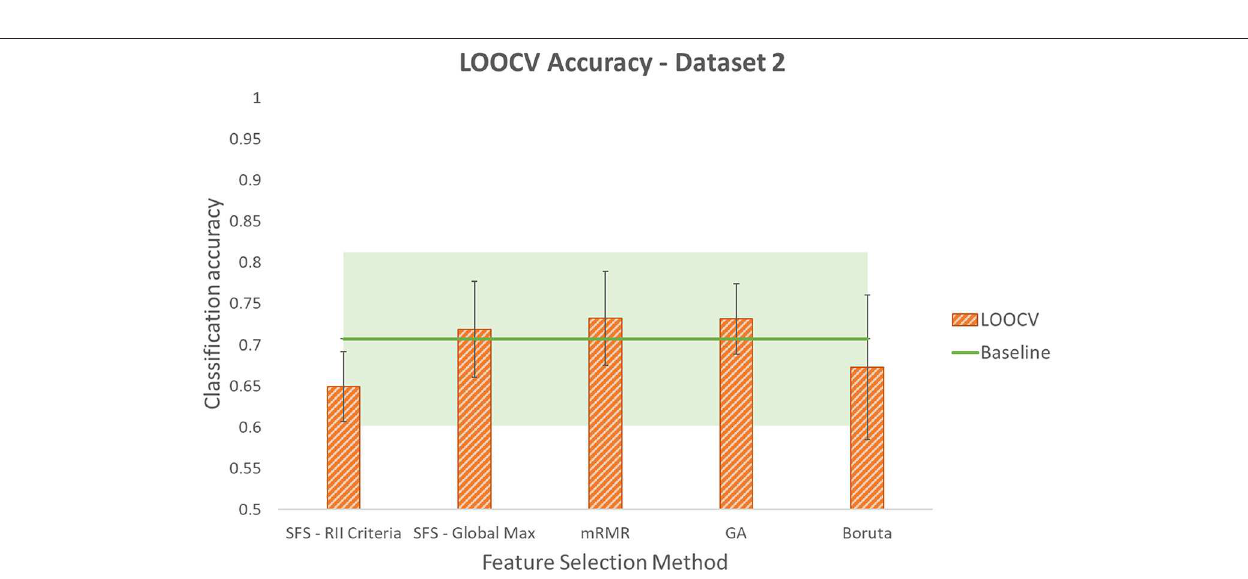
FIGURE 7 | Leave-One-Out Cross Validation accuracy using different feature selection methods for dataset2. Shaded area around the baseline indicates its standard deviation.